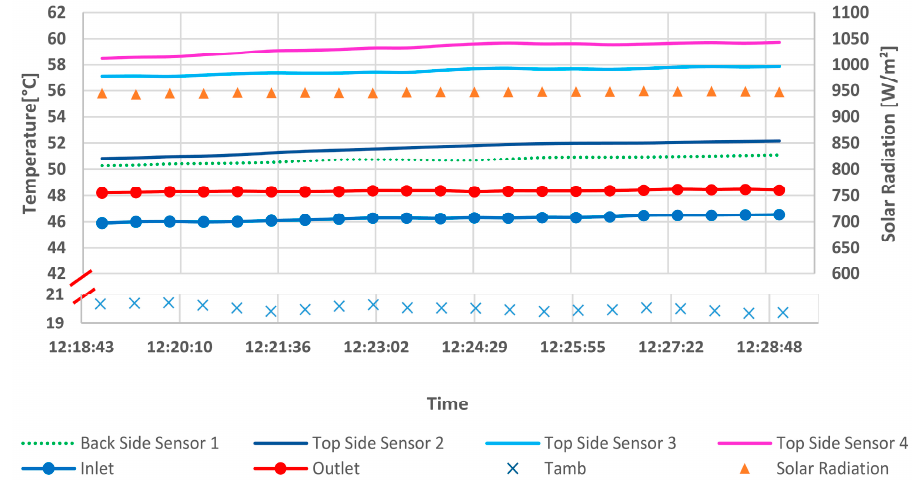
Figure 12. Measurement C: layers, water and ambient temperatures and solar radiation. The flow rate of measurement: 2.2 L/min.